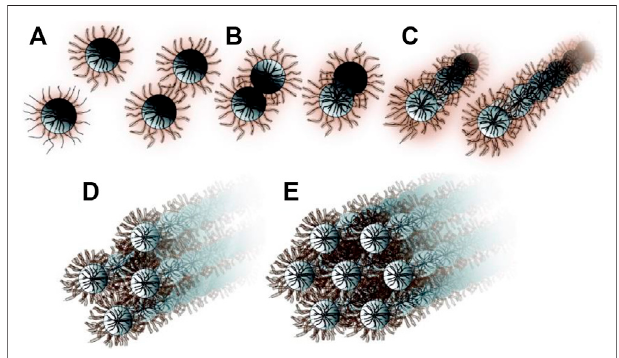
FIGURE 15 | Formation mechanism of COK-12. (A) Core – shell P123- silicamicelleformationbyincorporationofsilicateoligomersinthelayerofPEO chains extending toward the solution, (B) loss of steric stabilization at a critical point of silica addition, (C) spherical micelles aggregate to form cylindrical features, (D,E) agglomeration of cylinders eventually tohexagonally ordered structure upon fi nal addition of silica (reprinted with permission from Jammaer et al., 2011, Copyright 2011 American Chemical